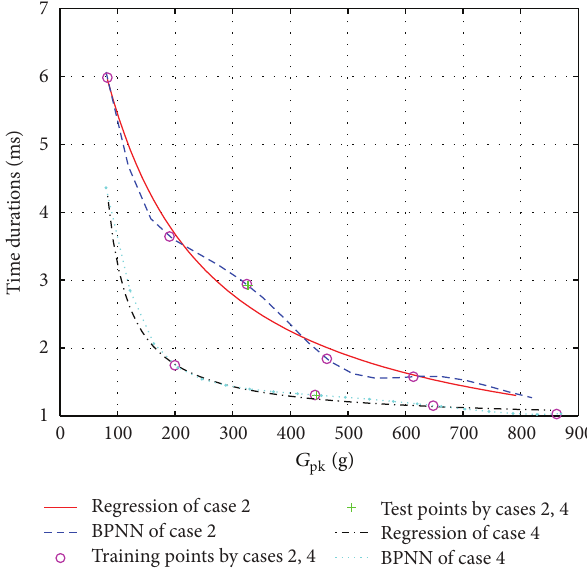
Figure 12: Fitting curve of 𝐷 versus 𝐺 in cases 2 and 4.